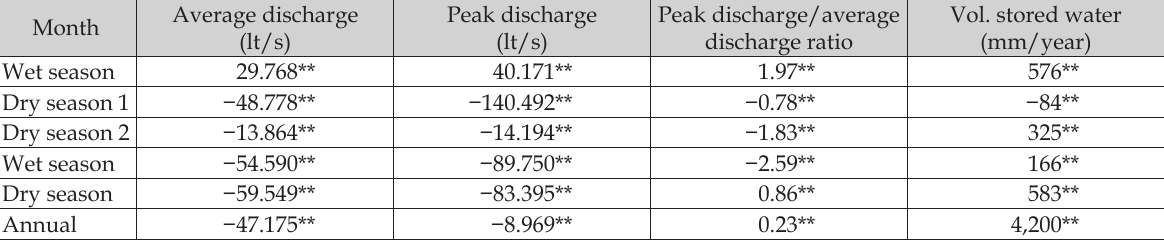
Table 3. Trends of changes in mean discharge, peak discharge, discharge ratio and water volume in the Sanen- rejo sub-watershed (2011–2019).